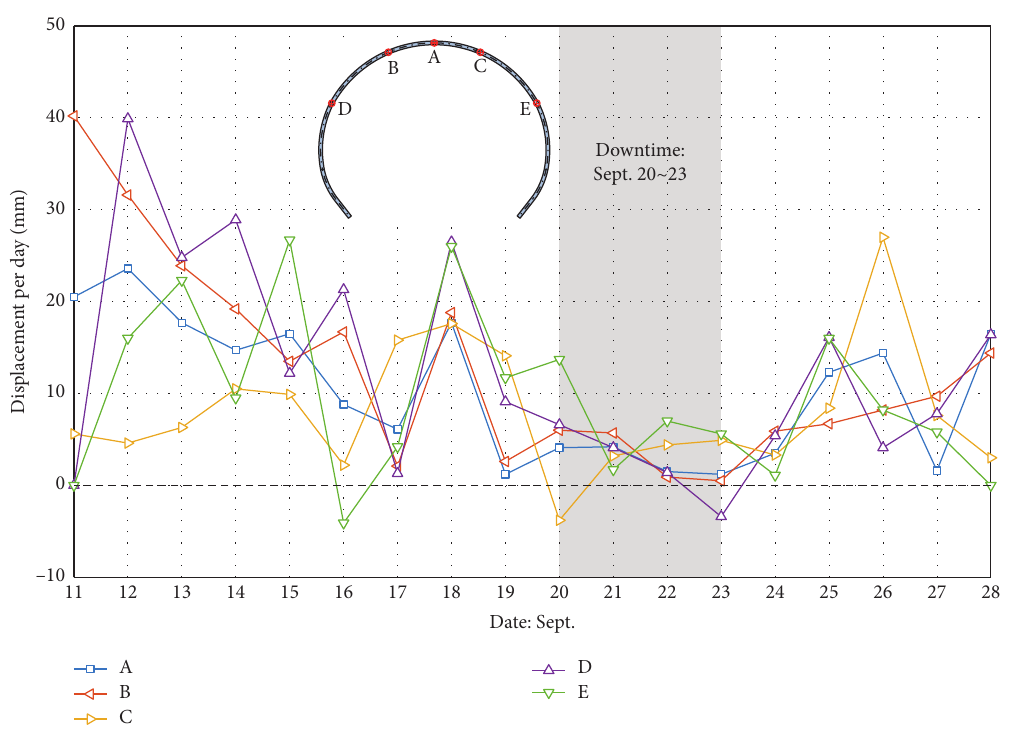
Figure 8: Displacement of monitoring points in chainage Z5K64+600 from September 11 th to 28 th in